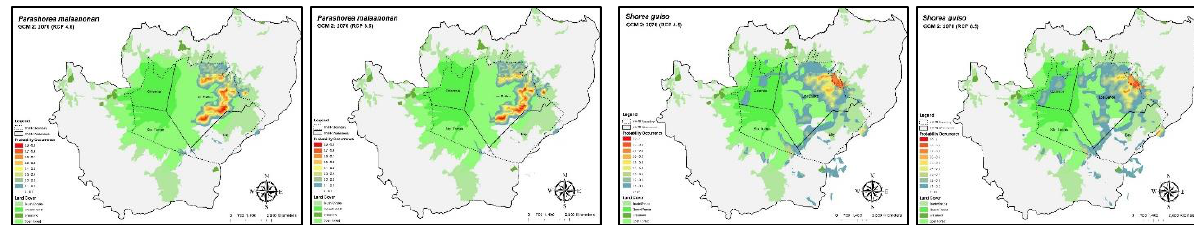
Figure 8. Predicted distribution of Parashorea malaanonan (L) and Shorea guiso (R) for GCM-2 by year 2050 under RCP 4.5 and RCP 8.5.